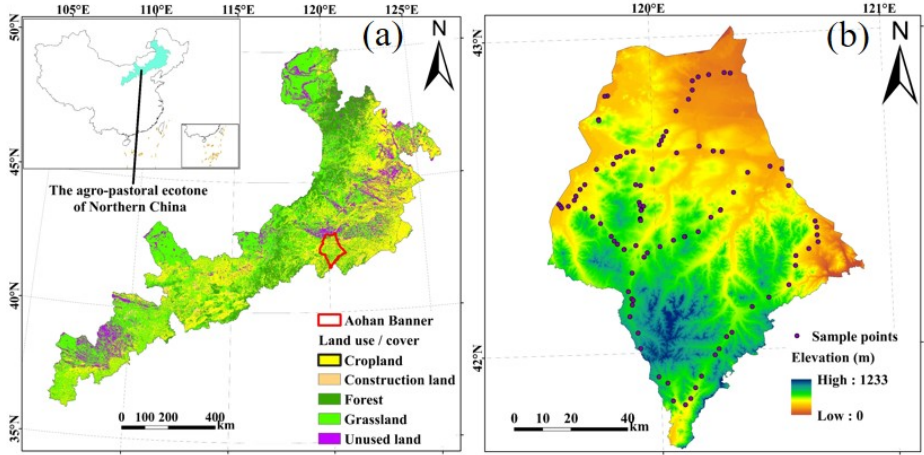
Figure 1. ( a ) Locations of the agro-pastoral ecotone of northern China and their relationships with the land-use and cover types in 2015. ( b ) Locations of the sampling sites with a relative elevation map in the study